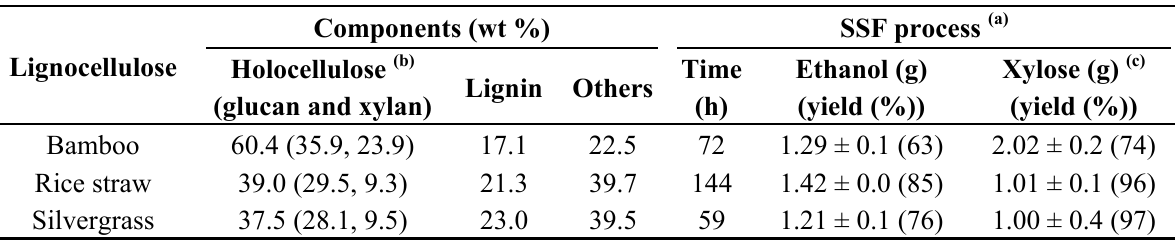
Table 1. Production of ethanol and xylose through SSF of